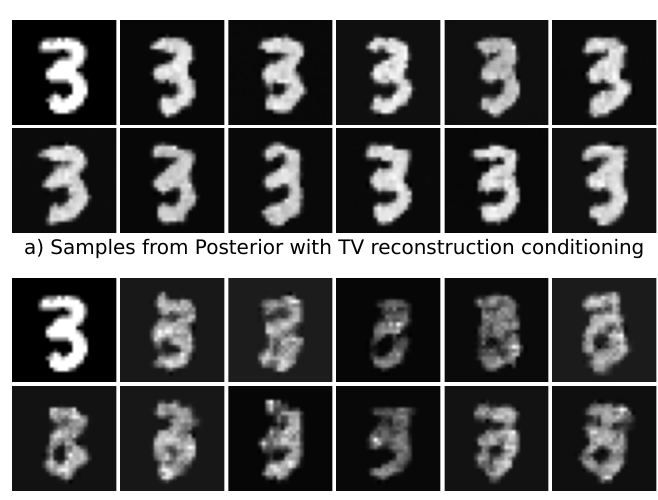
Figure 7. Samples from the posterior learned by the cINN. The ground-truth sample is shown in the upper-left corner. In ( a ), we used the conditioning based on the TV-regularized reconstruction, and in ( b ), the conditioning was chosen as the generalized inverse. It can be seen that individual samples from the generalized inverse conditioning do not look